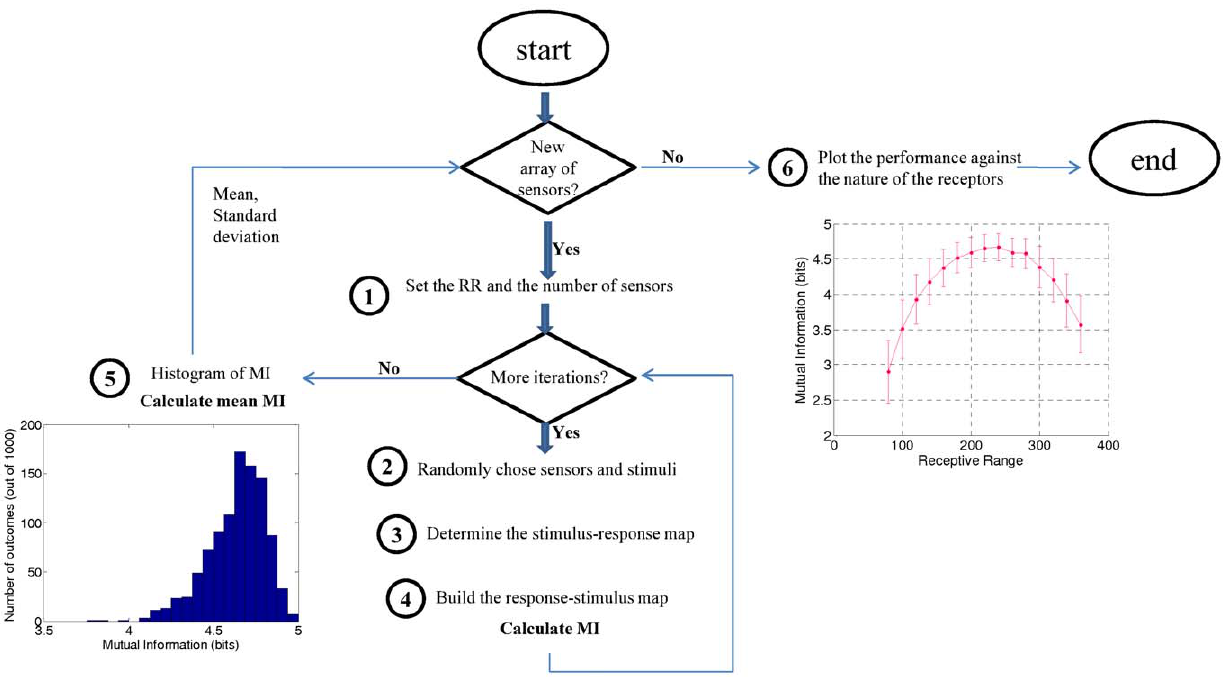
Figure 1. Method to estimate the coding capacity of groups of receptors. This is the routine to calculate the MI for different receptor type ensembles. In step 1 we set the number and the RR of receptors. In step 2 we randomly select the stimuli and receptors from the database. In step 3, the stimulus-response map is calculated, and reversed in step 4 to calculate MI. We select a new set of receptors (of the same type) and stimuli and repeat the cycle thousands of times. We obtain the histogram of MI and we calculate the mean value and the standard deviation of the values obtained for the same type of receptors (step 5). Then, we change the number and the RR of receptors (step 1) and compute the routine again. Finally, in step 6, we plot the performance of the ensemble across the type of